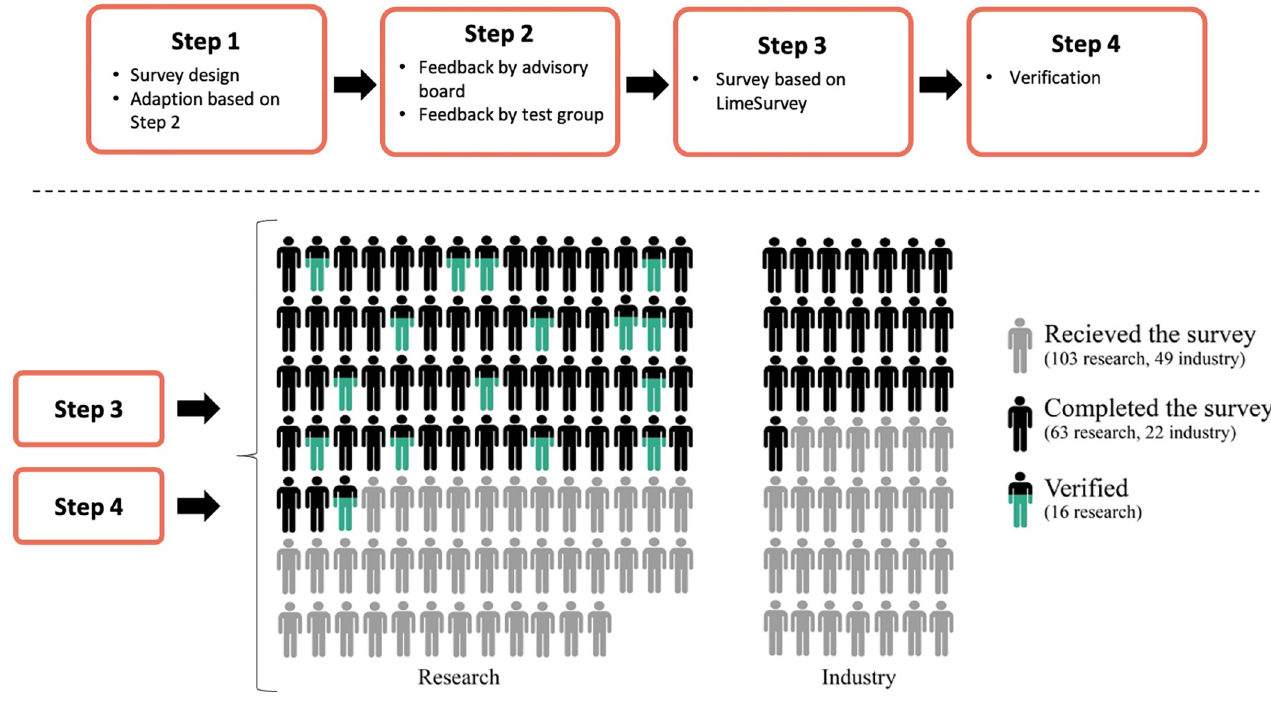
Fig 1. Four-step process of the empirical